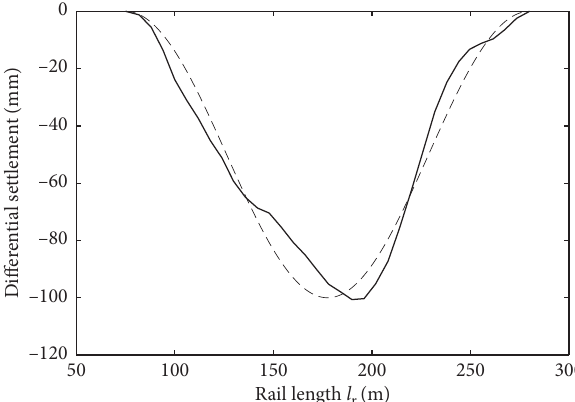
Figure 12: Comparison of theoretical tunnel settlement ( ) and practical tunnel settlement ( ).